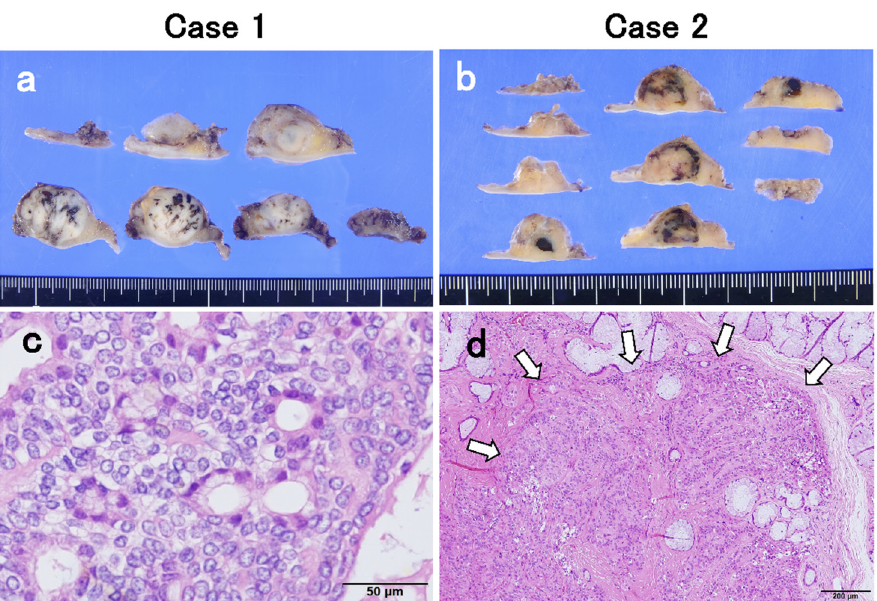
Figure 2. ( a , b ) Photographs of the specimen. Macrographically, the cut surface of the resected tumors revealed a spherical tumor, measuring 19.5 and 12.5 mm in maximum diameter, respectively. Apparent invasion findings to surrounding tissue were not detected at macro-level. Tumors included some blacky speckled structure. ( c , d ) Hematoxylin and eosin staining (HE) showing a component with dense growth of acidophilic tumor cells and a component with cord-like or network-like growth of epithelioid-like neoplastic myoepithelial cells, and a biphasic glandular structure consisting of glandular cavities with acidophilic vesicles and neoplastic myoepithelial cells with clear vesicles outside the cavities. Bar, 50 um. ( d ) In Case 2, although fission images are moderate, the apparent invasion to the preexisting minor salivary glands can be identified (arrows). HE staining. Bar, 200 um.